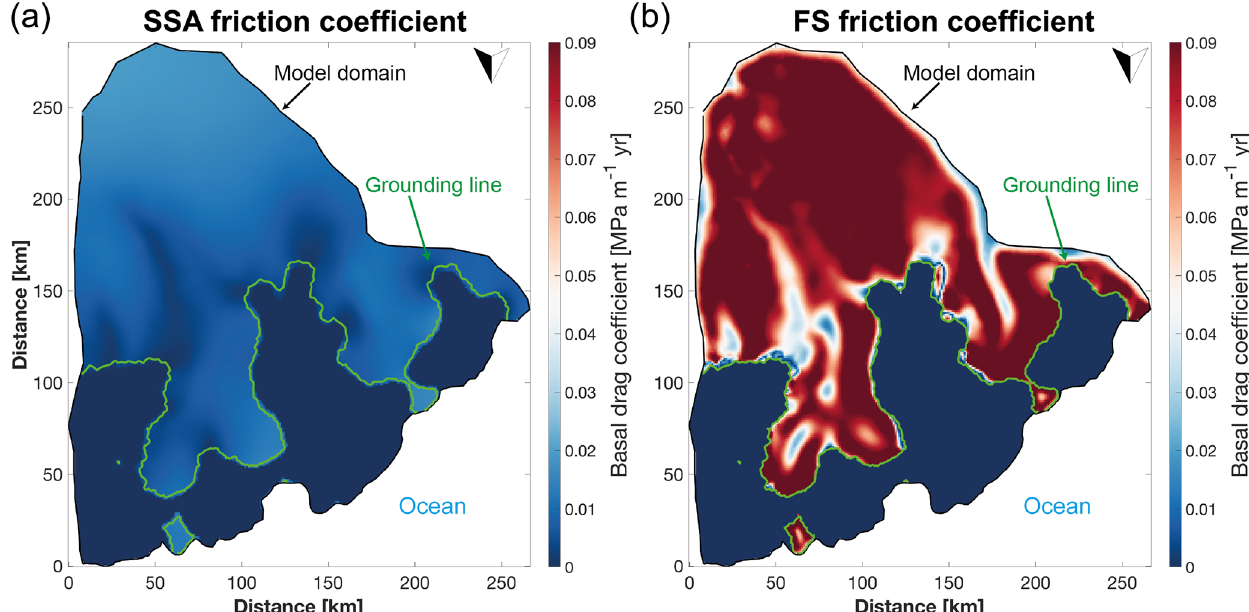
Figure 5. Inferred basal traction fields C using (a) the SSA model and (b) the FS